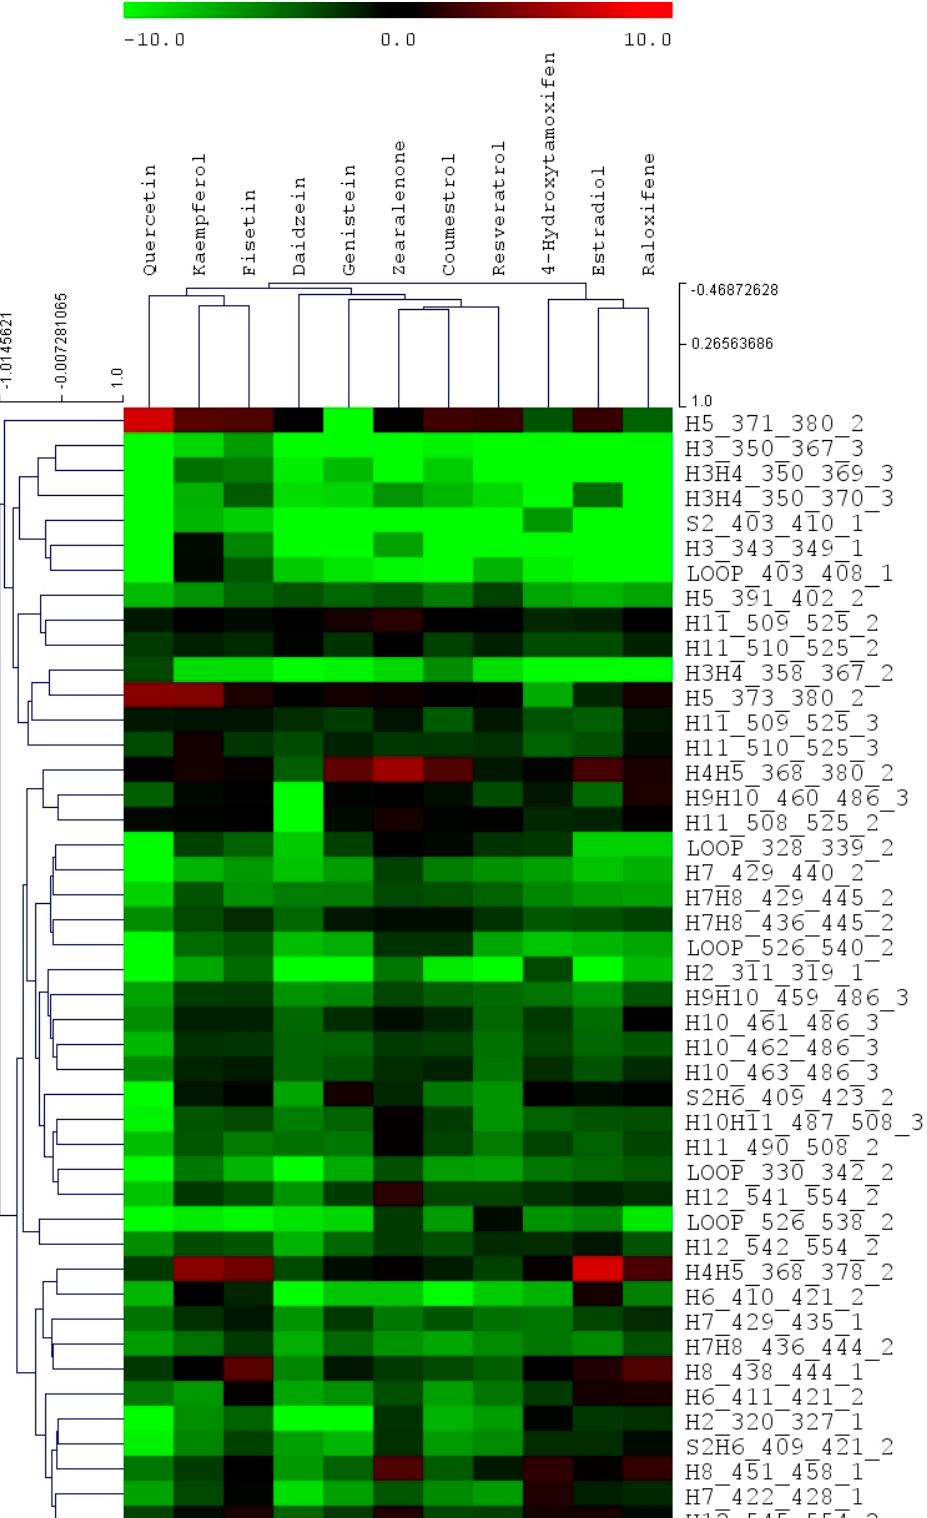
Figure 2. Cluster analysis of all analyzed compounds. The names of compound are shown above the bar view, and the peptide regions are shown on the right of the bar view. The color represents the differential deuterium level of each peptide in the absence and presence of compounds. The scale is presented in percentage (%).